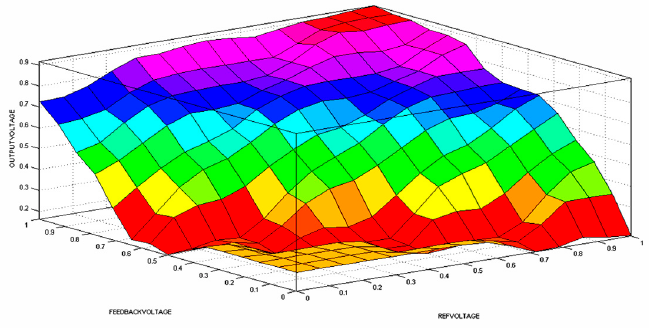
Figure 22. Surface plot for Rule 3.